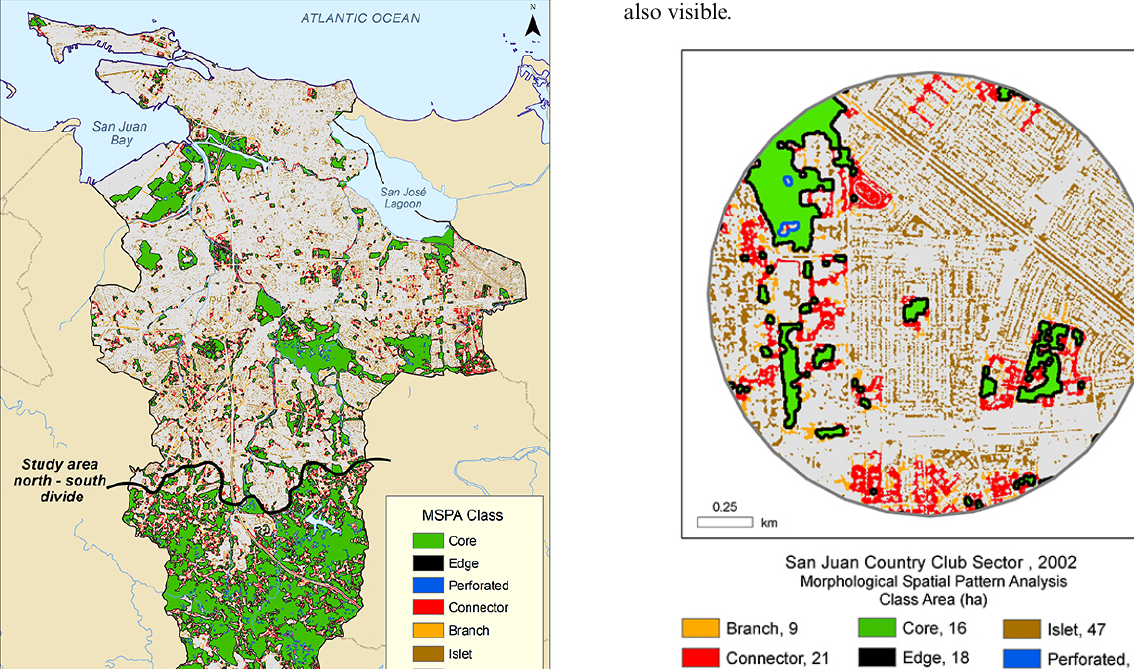
Fig. 3. Geographic distribution of green cover spatial patterns in San Juan, Puerto Rico, using morphological spatial pattern analysis (MSPA) classes.